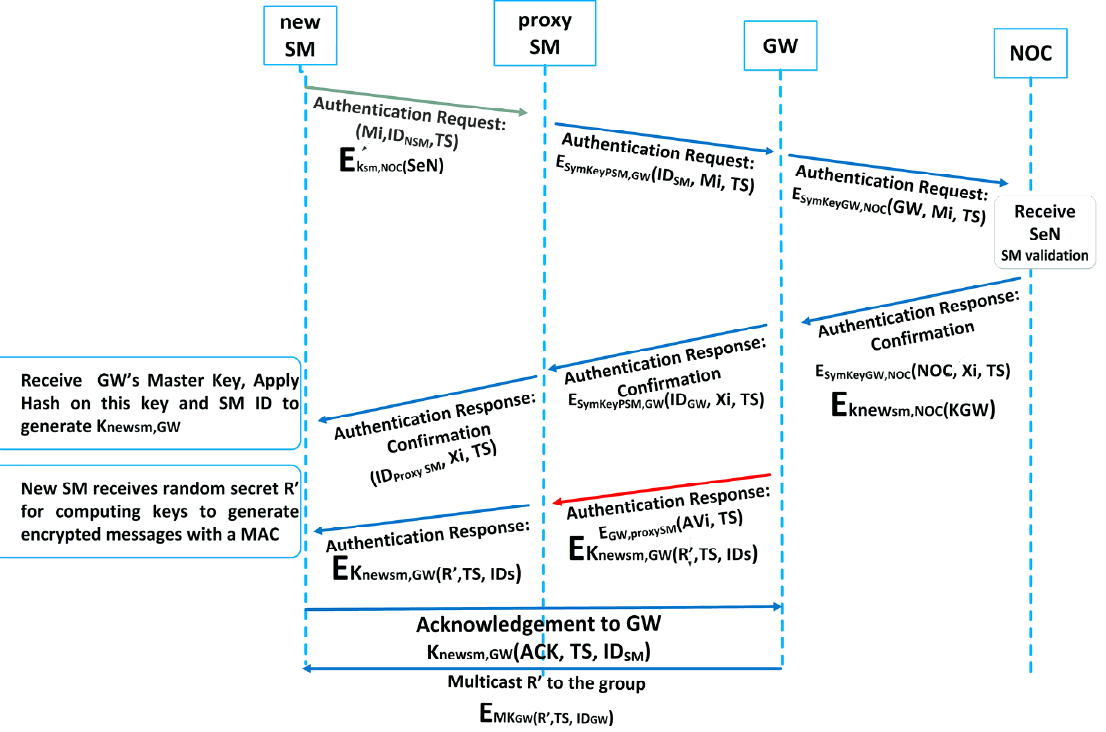
Figure 7. Authentication of a SM—Case 2.